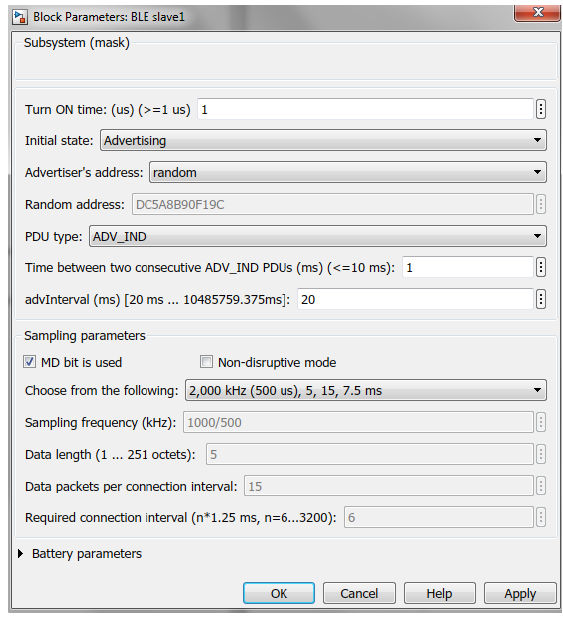
Figure 10. Slave’s dialog